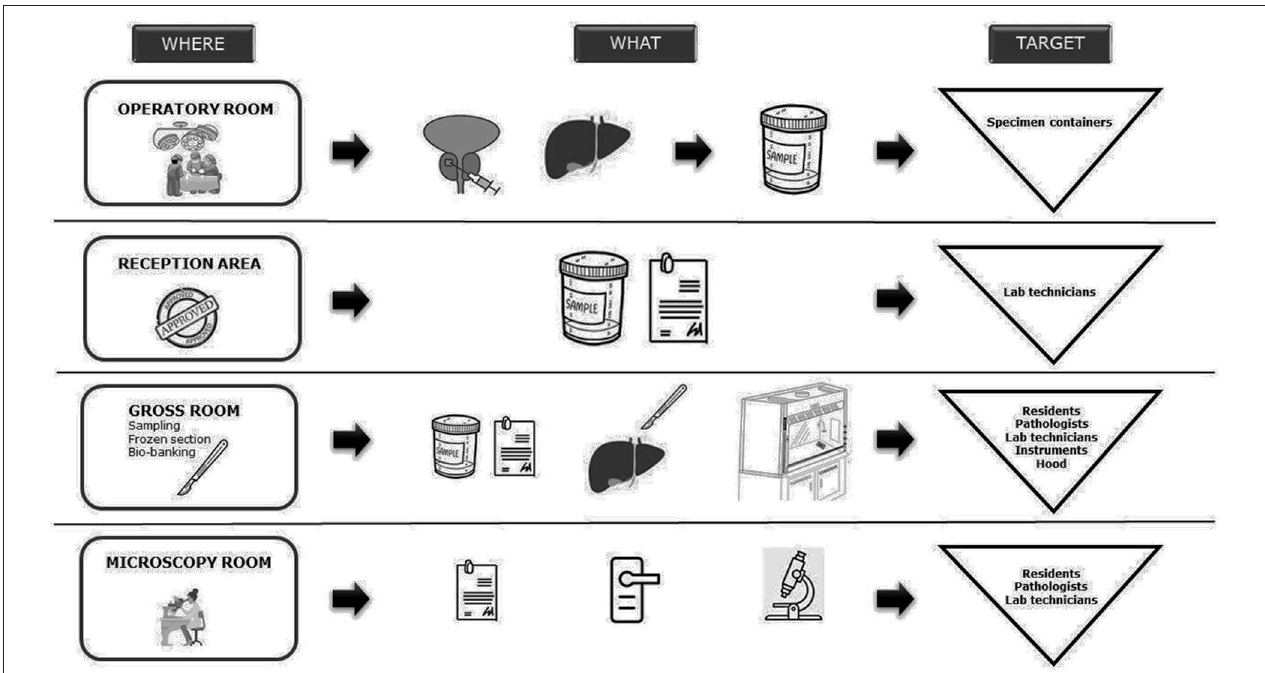
FIGURE 1 | Chain of contagion in a Pathology